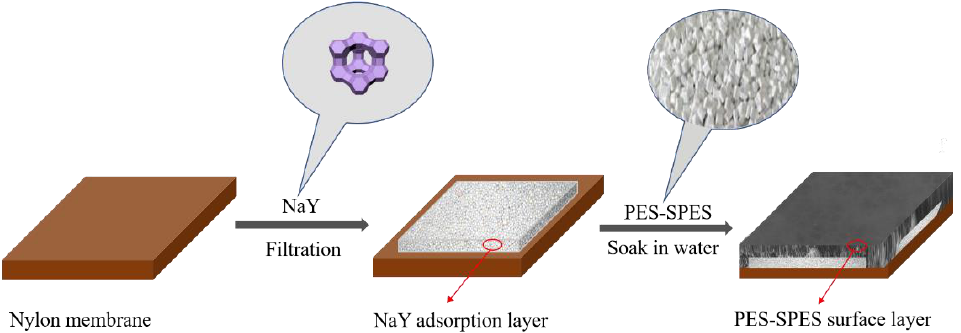
Figure 1. Schematic diagram of the preparation of PES-SPES/NaY zeolite/nylon sandwich adsorptive membrane.